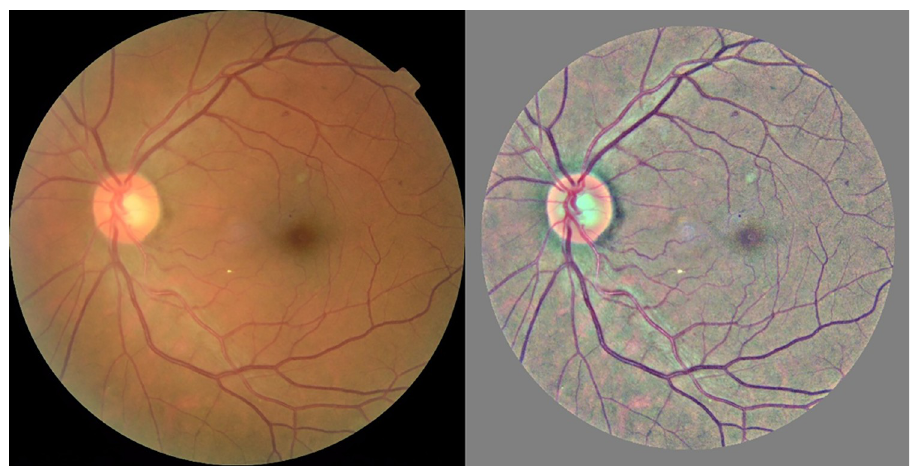
Fig 3. Contrast enhancement of the Kaggle EyePACS fundus image. The Gaussian blur technique was applied to the raw fundus image (left). This technique minimizes intensity and contrast variability in fundus image dataset (right).